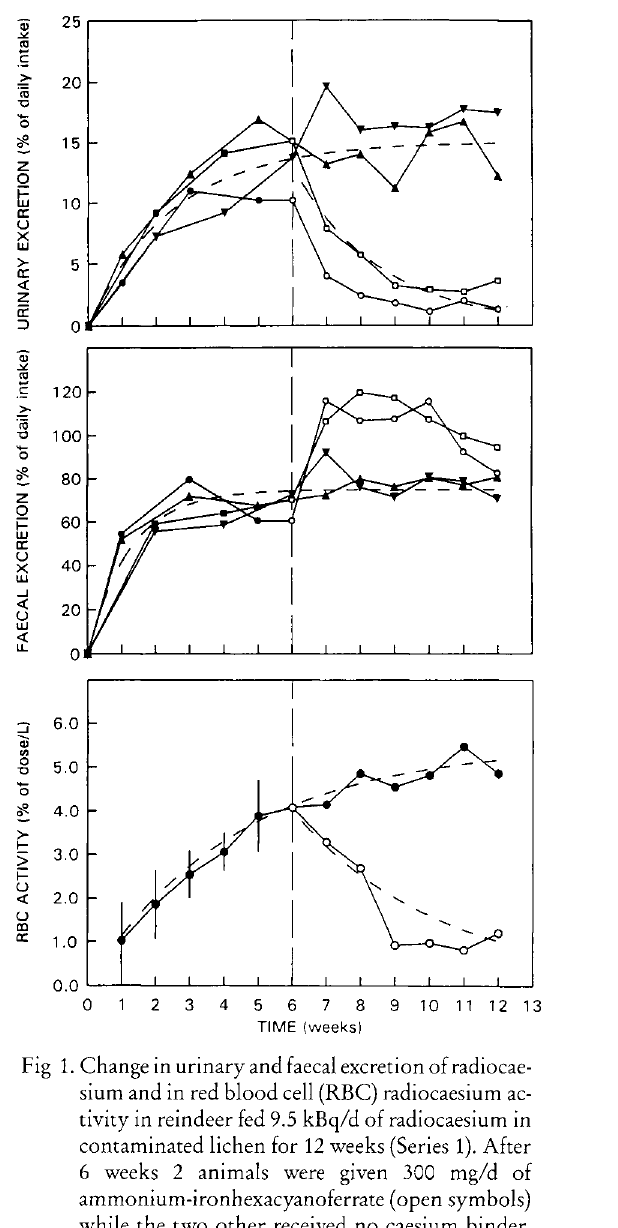
Fig 1. Change in urinary and faecal excretion of radiocae sium and in red blood cell (RBC) radiocaesium ac tivity in reindeer fed 9.5 kBq/d of radiocaesium in contaminated lichen for 12 weeks (Series 1). After 6 weeks 2 animals were given 300 mg/d of ammonium-ironhexacyanoferrate (open symbols) while the two other received no caesium binder. RBC radiocaesium concentrations (bottom graph) are given as means and standard deviations during the period when the no caesium binder was given. Curves with broken lines represent the fitted expo nential formulas for the build up of radiocaesium